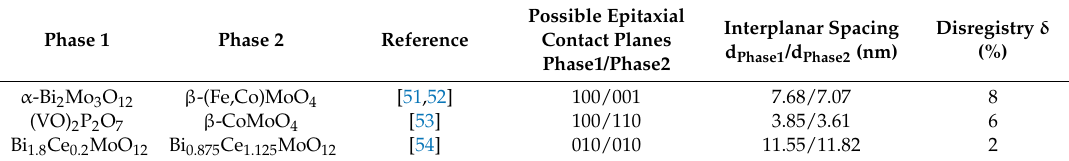
Table 3. Examples of synergistic phase interactions in metal-oxide catalysts and possible epitaxial contact planes.